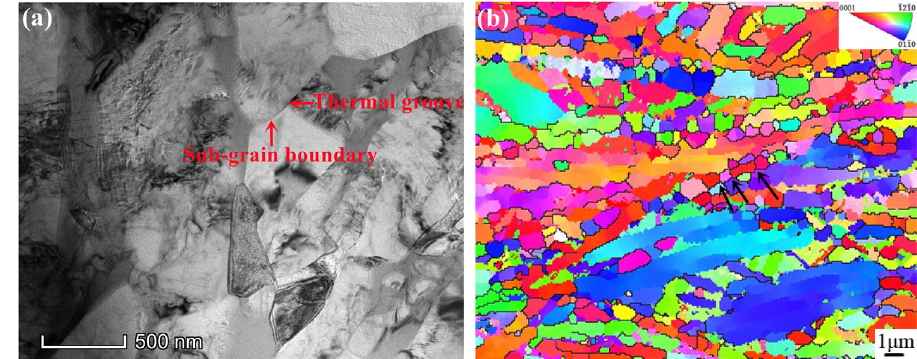
Figure 18: The morphology of substructure within lamellar α : ( a ) thermal groove and sub - grain boundary observed by TEM and ( b ) separation of lamellar α observed by electron backscatter di ff